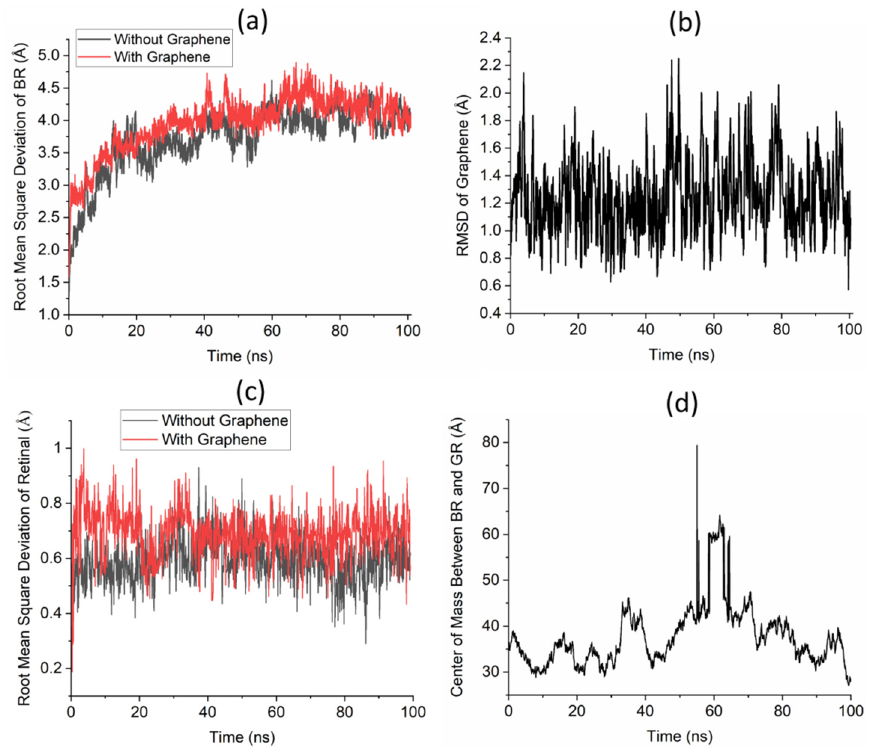
Figure 2. Stability analysis of bR and graphene during the 100 ns simulations: ( a ) Root Mean Square Deviation of bR with and without graphene; ( b ) Root Mean Square Deviation of graphene. ( c ) Root Mean Square Deviation of Retinal in the presence and absence of graphene; ( d ) Distance between the center of masses of bR and graphene.